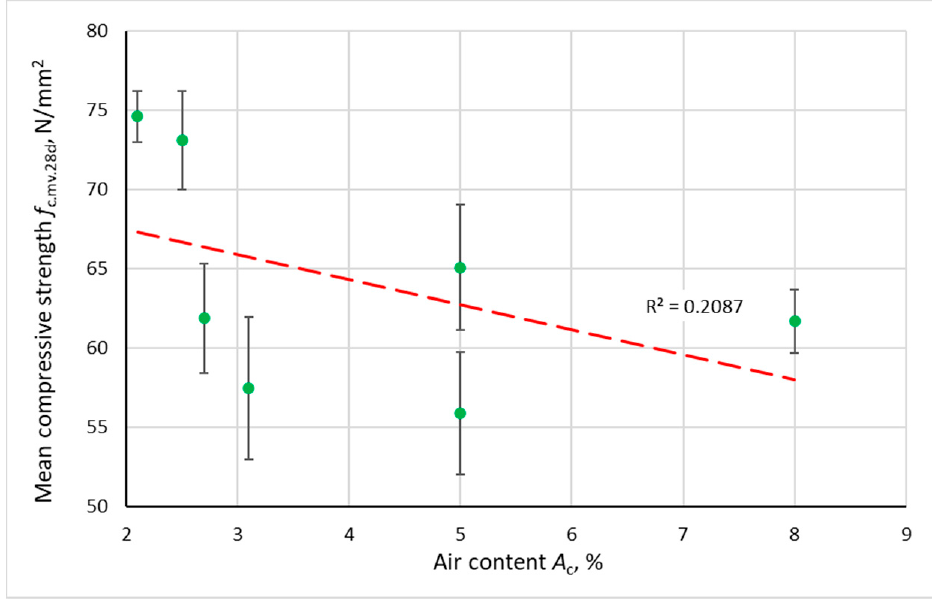
Figure 7. Dependence of the mean compressive strength of concrete after 28 days of curing on the air content in the concrete mix.